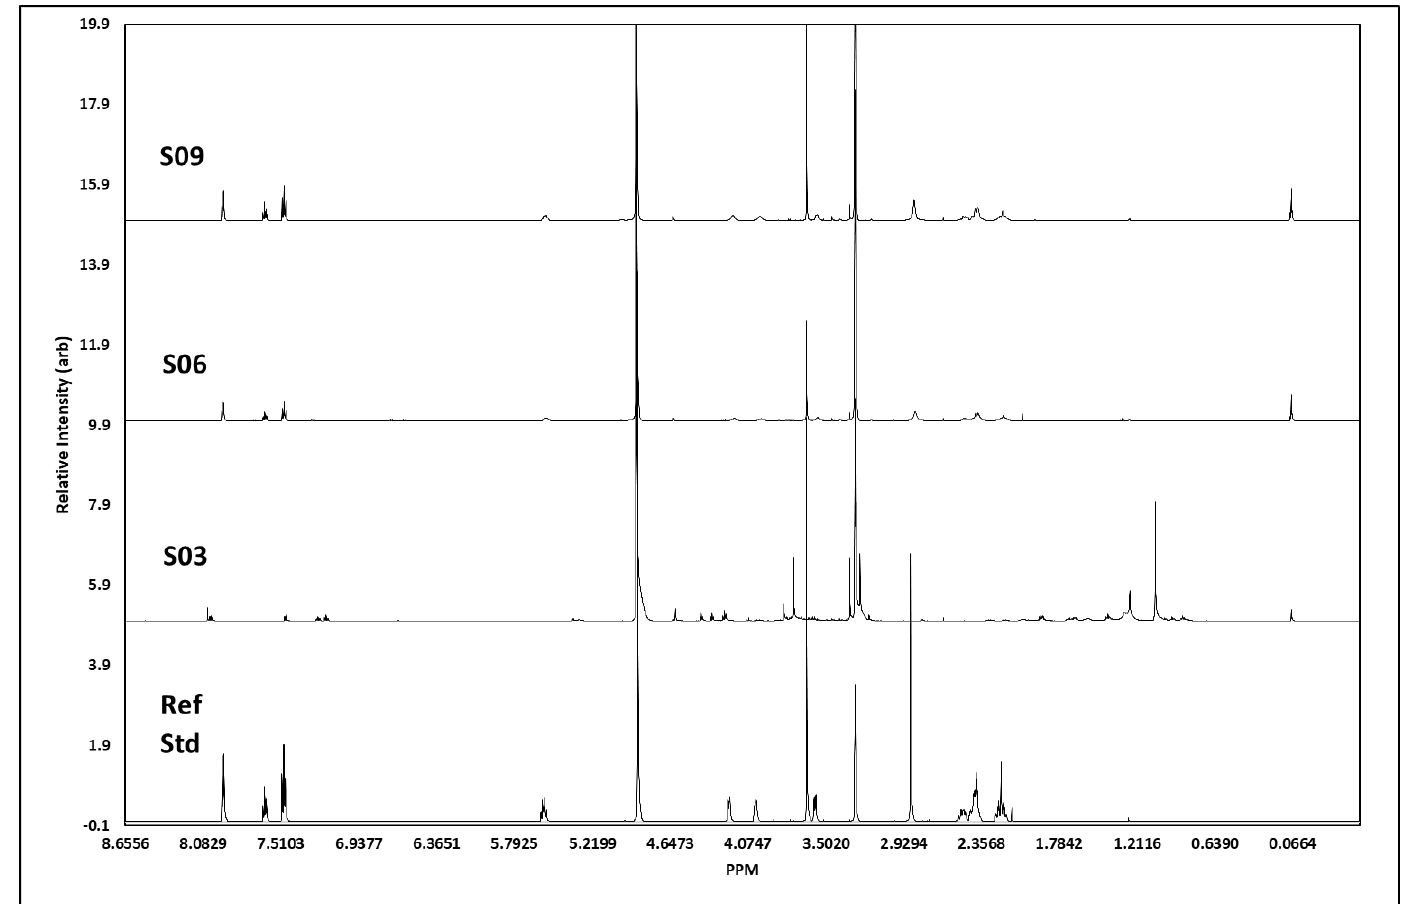
Figure 6. 1 H NMR spectral data. Figure shows spectral trace for each cocaine sample, S03, S06 and S09, with a pharmaceutical reference standard (Ref Std) below. Spectra shows distinct areas of singlet and multiplet signatures, concurrent with those visible in the reference standard, as expected with 1 H NMR. The additional noise in the surrendered sample spectra is indicative of street samples of cocaine, which has been cut with unknown agents.